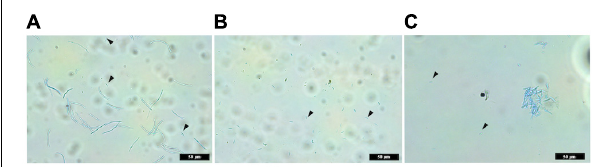
FIGURE 7 | Images comparing macropycnidospores and micropycnidospores obtained from wheat leaves (cv. Riband) infected with the IPO323 strain and (cid:49) ztvelB mutants. Spores were harvested from infected wheat leaves at 28 days post-inoculation and stained with lactophenol cotton blue. Images representative of all three (cid:49) ztvelB knock-out mutant strains tested against the IPO323 strain. Experiments were carried out in triplicate with 7–12 technical replicates each time. Arrowheads indicate micropycnidiospores (A) IPO323 produces both macropycnidiospores and micropycnidiospores. (B) (cid:49) ztvelB mutants only produce micropycnidospores. (C) Aggregation of micropycnidiospores obtained from the (cid:49) ztvelB